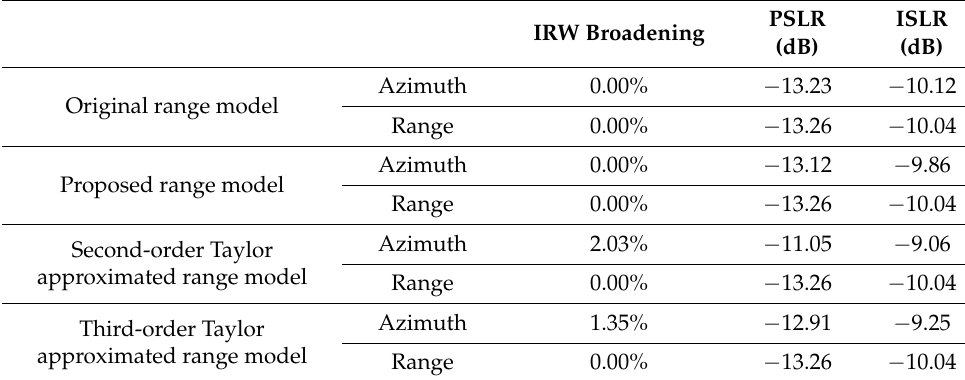
Table 2. Measured quality parameters.